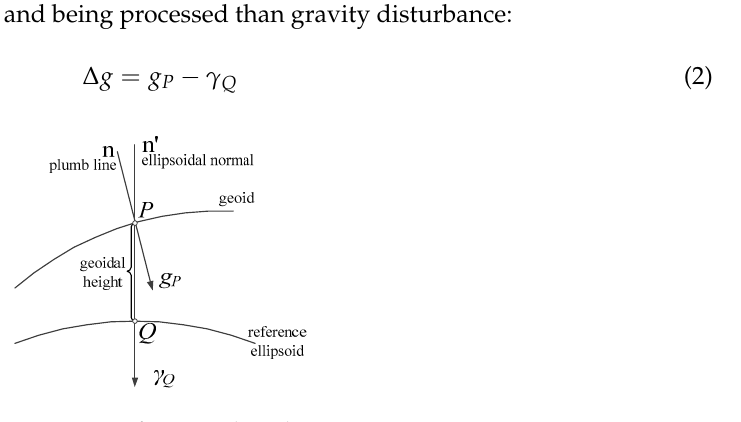
Figure 1. Description of gravity disturbance vector.